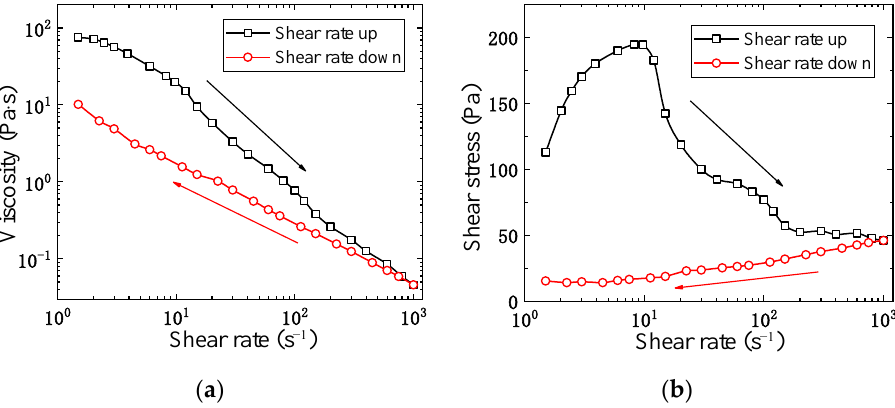
Figure 4. ( a ) Viscosity and ( b ) shear stress curves of the kerosene gel in the thixotropic loop test.